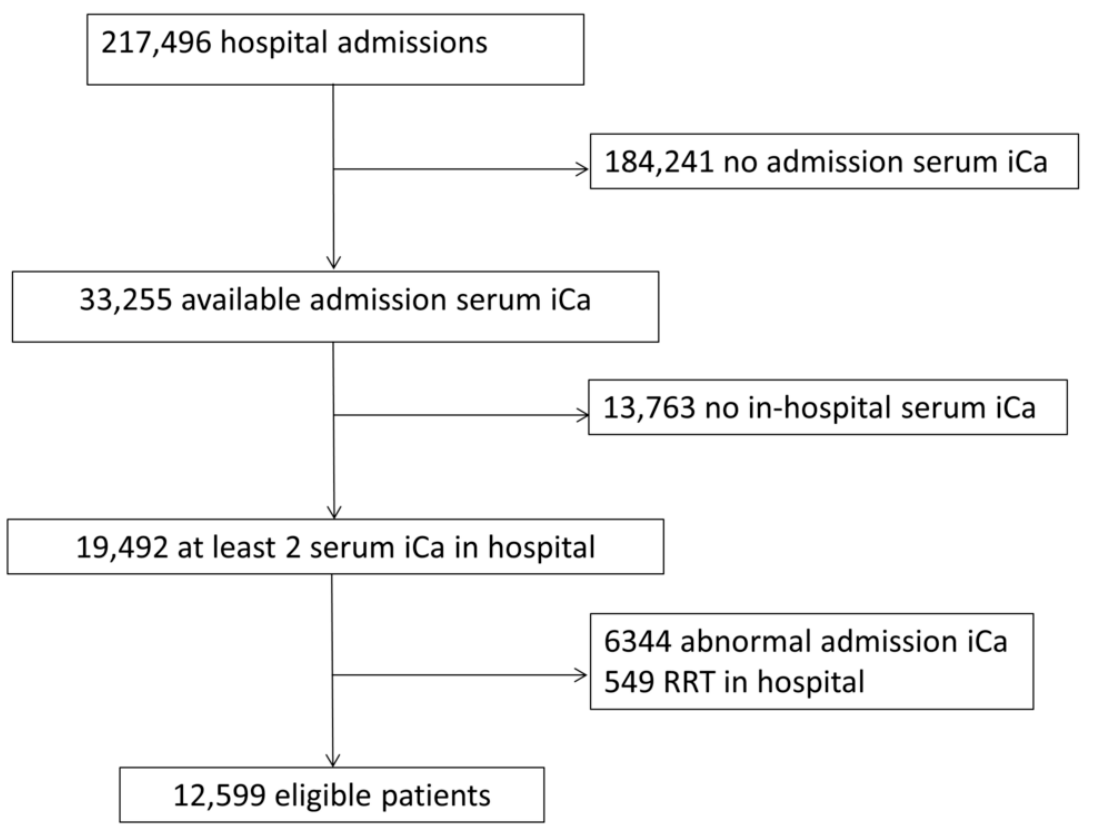
Figure 1. Study selection